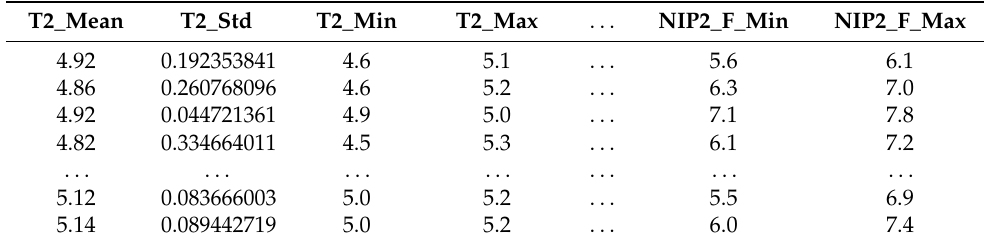
Table 1. Statistical features computed from the input data.